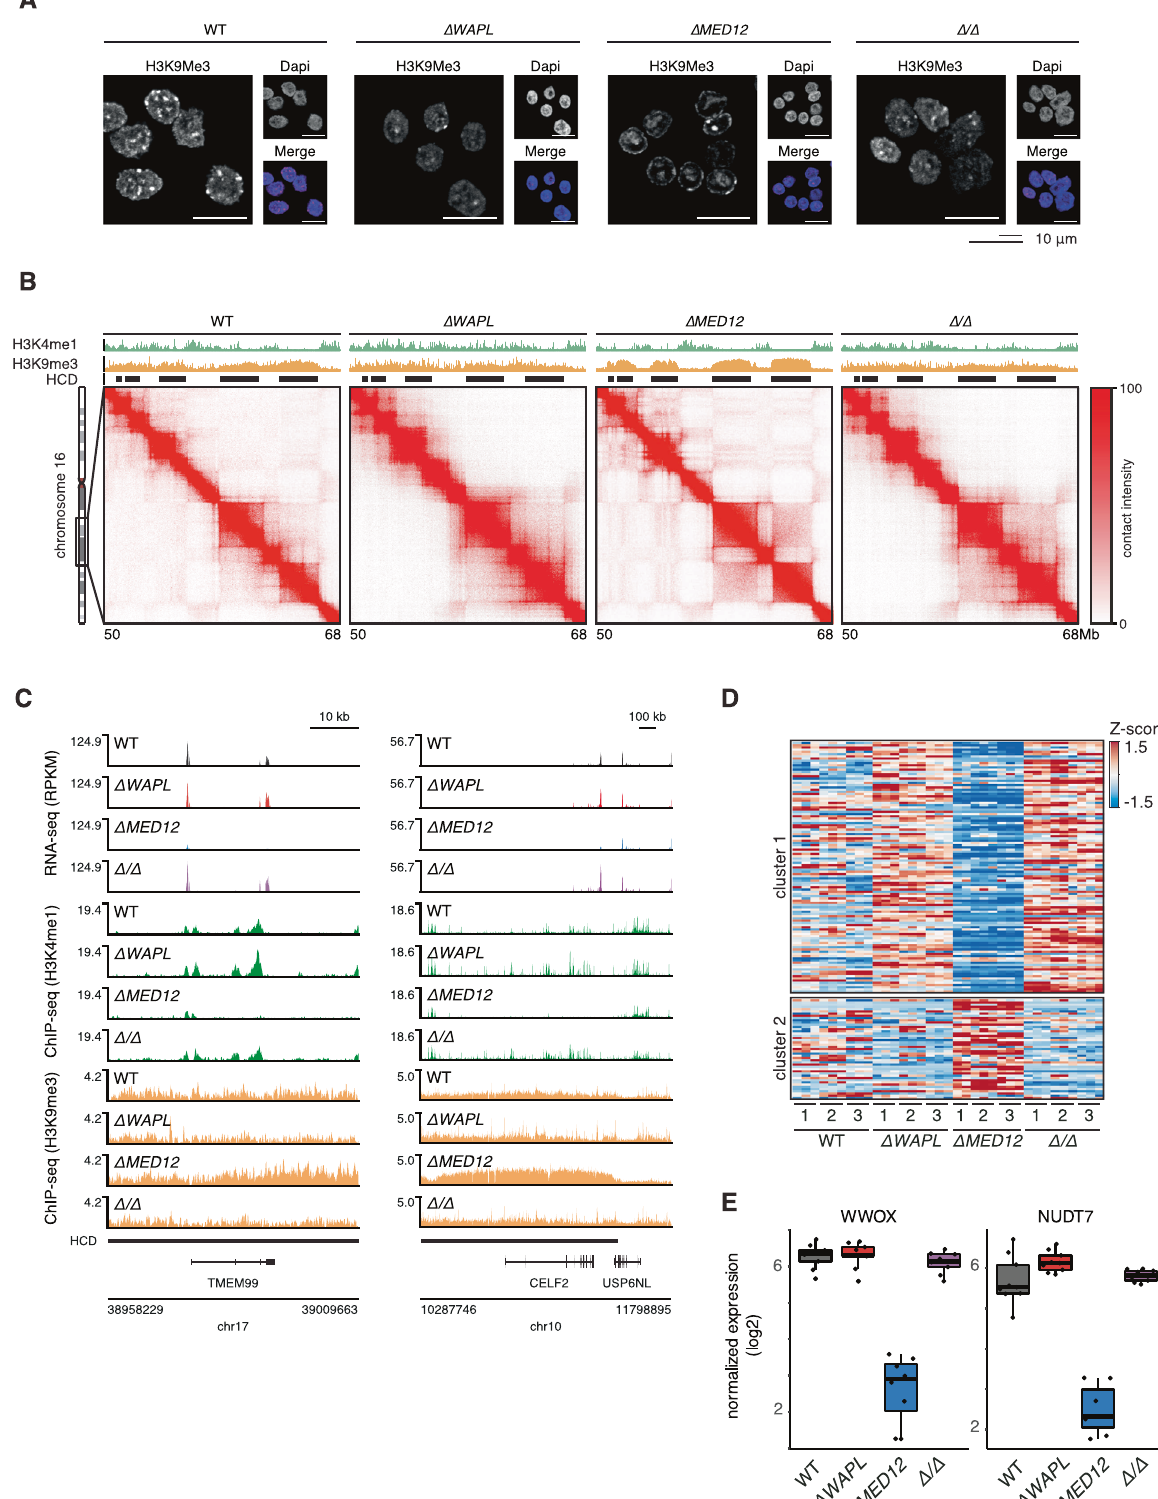
Compartments can be subdivided into submegabase-sized topologically associating domains (TADs). These are formed by cohesin-mediated loop extrusion 10,12,27 . We analyzed what hap- pens to TAD borders (i.e. genomic regions separating two TADs) that are located in HCDs. We fi nd that TAD borders that become